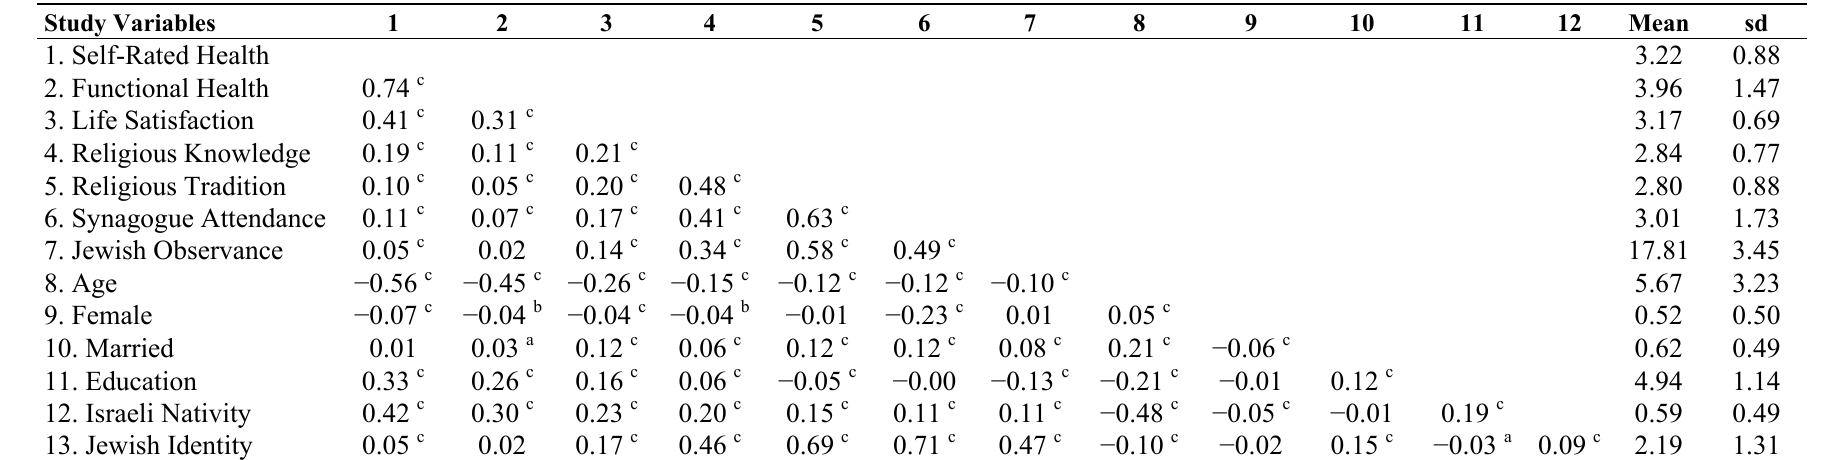
Table 1. Descriptive statistics and Pearson correlations for study variables.